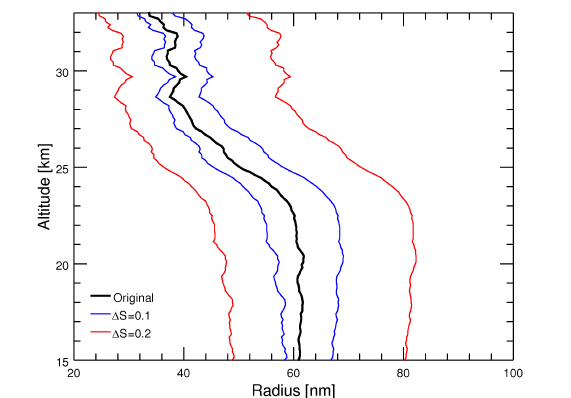
= ± 0.04) for measurements of March 2013. 0